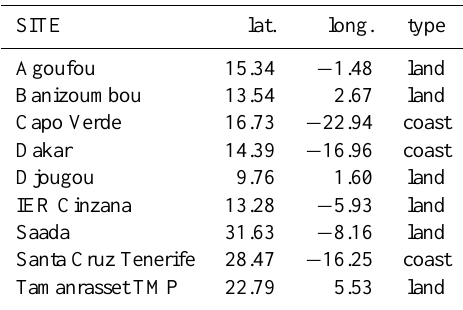
Table 3. AERONET sites considered in the comparison: name, lat- itude, longitude and type (land or coast). The same sites are shown in Fig.